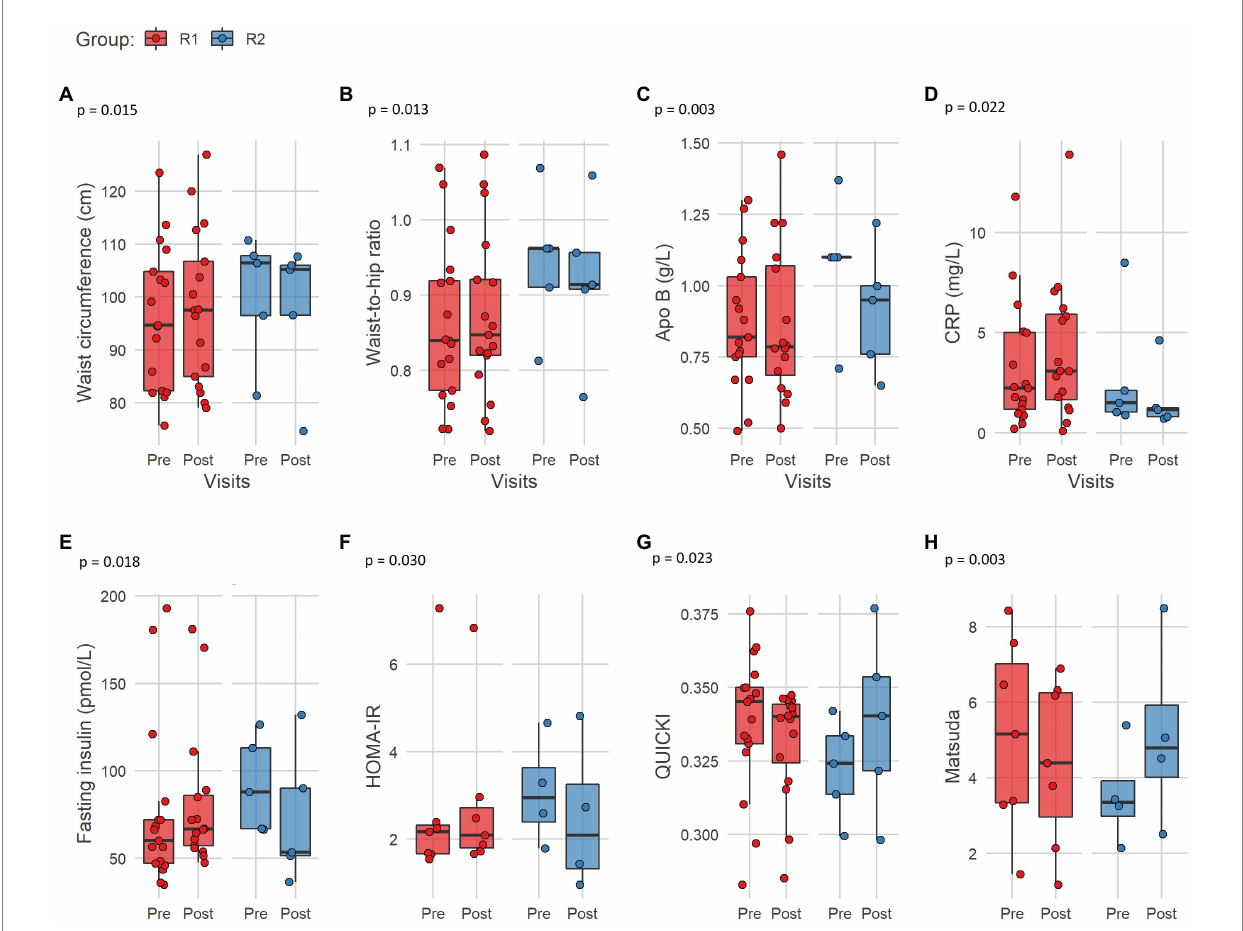
FIGURE 2 Metabolic differences between pre- and post-intervention by response subgroup. Panels (A) – (H) show all significant differences in metabolic parameters between pre- and post-intervention timepoints for type 1 responders (red) and type 2 responders (blue) derived from a linear mixed model. p Values shown above each panel represent the p for group × visit interaction. Differences accounted for age and sex and resulted from the interaction between the effects of group and timepoint. Each point represents a participant. The mean is represented by the horizontal line, and the standard error is represented by the vertical lines. QUICKI, Matsuda, HOMA-IR and waist-to-hip ratio have no